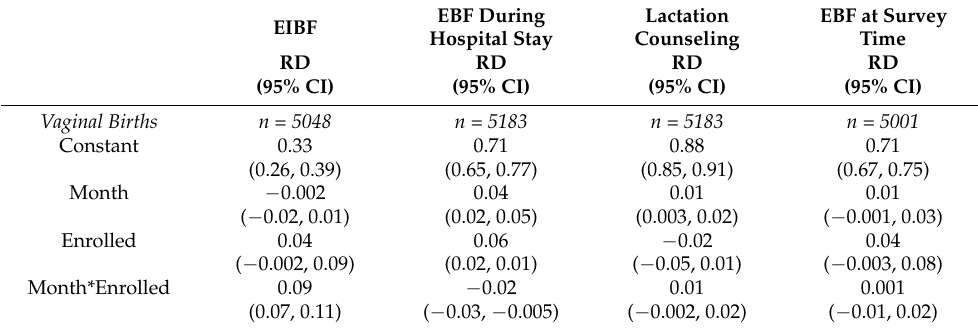
Figure 2. Rates of the main outcomes relative to timing of hospital enrollment separated by vaginal vs. cesarean births. ( A ) Early initiation of breastfeeding in the hospital; ( B ) EBF in the hospital; ( C ) receiving lactation counseling in the hospital; ( D ) EBF at time of survey. Table 3. Risk difference from segmented regression models stratified by birth